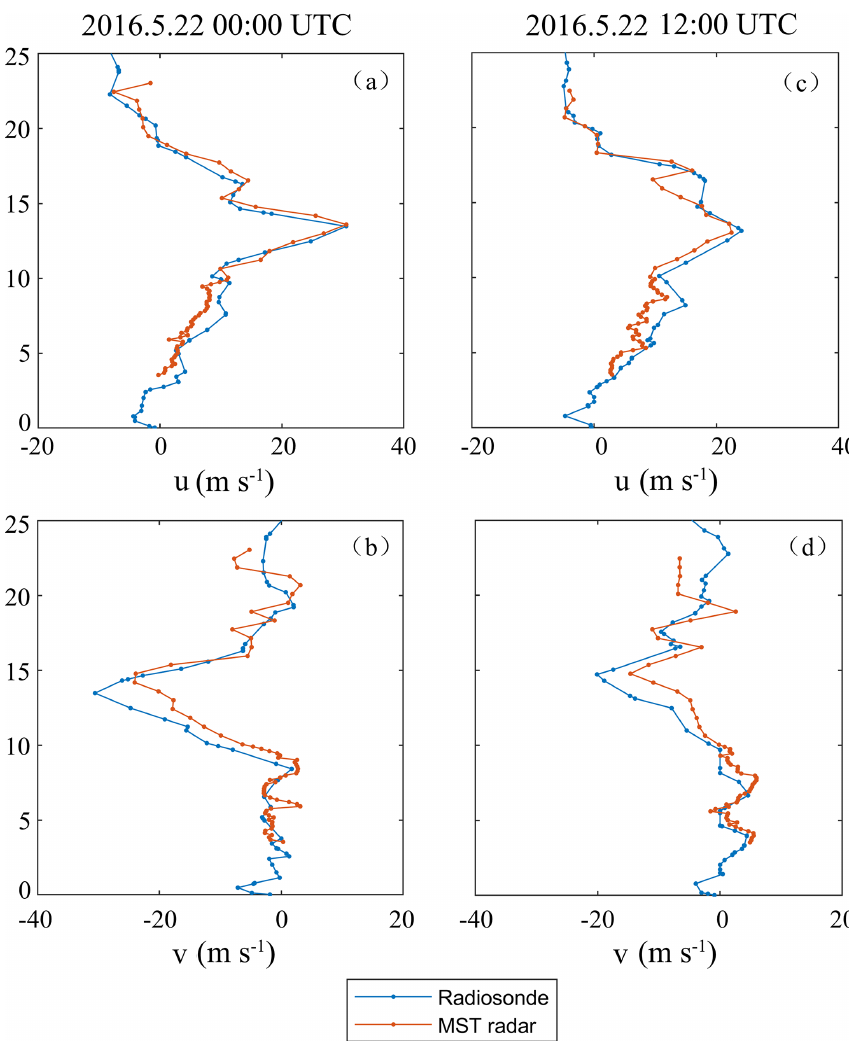
Figure 9. The zonal ( u ) and meridional ( v ) winds at heights of 3.5–25km observed by the Wuhan MST radar (red lines) and the radiosonde (blue lines) at 00:00UT (a, b) and 12:00UT (c, d) on 22 May